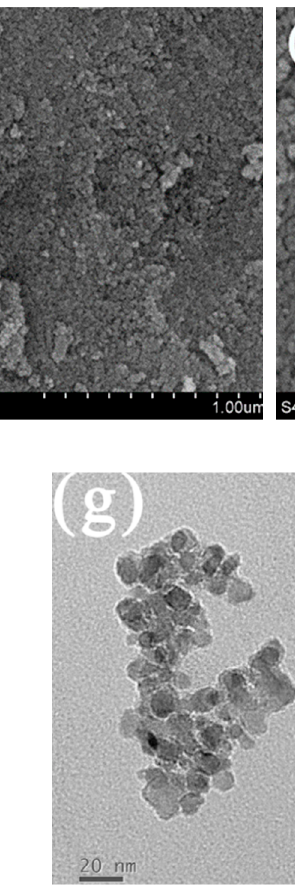
Figure 3. SEM images of nano-TiO 2 at rotating speeds of the packing of 400 rpm ( a,b ), 800 rpm ( c,d ), and 1200 rpm ( e,f ). TEM images of nano-TiO 2 at a rotating speed of the packing of 800 rpm ( g ).